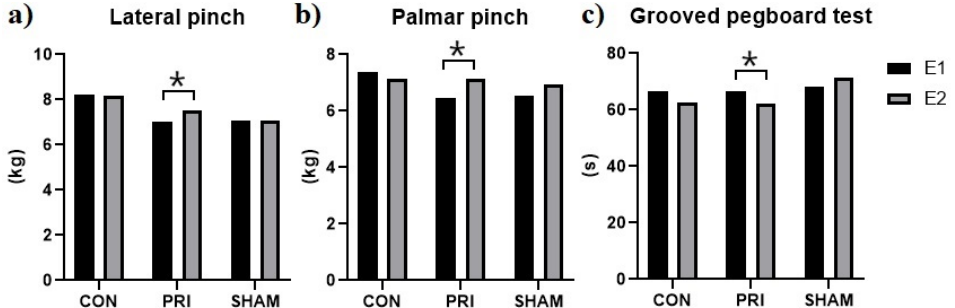
Figure 4. Motor performance assessment. ( a ) Lateral pinch, ( b ) Palmar pinch, ( c ) Grooved pegboard test. Only the PRI group showed significant improvement in the lateral and palmar pinch and the grooved pegboard tests. * Significant differences were determined using paired t -tests.